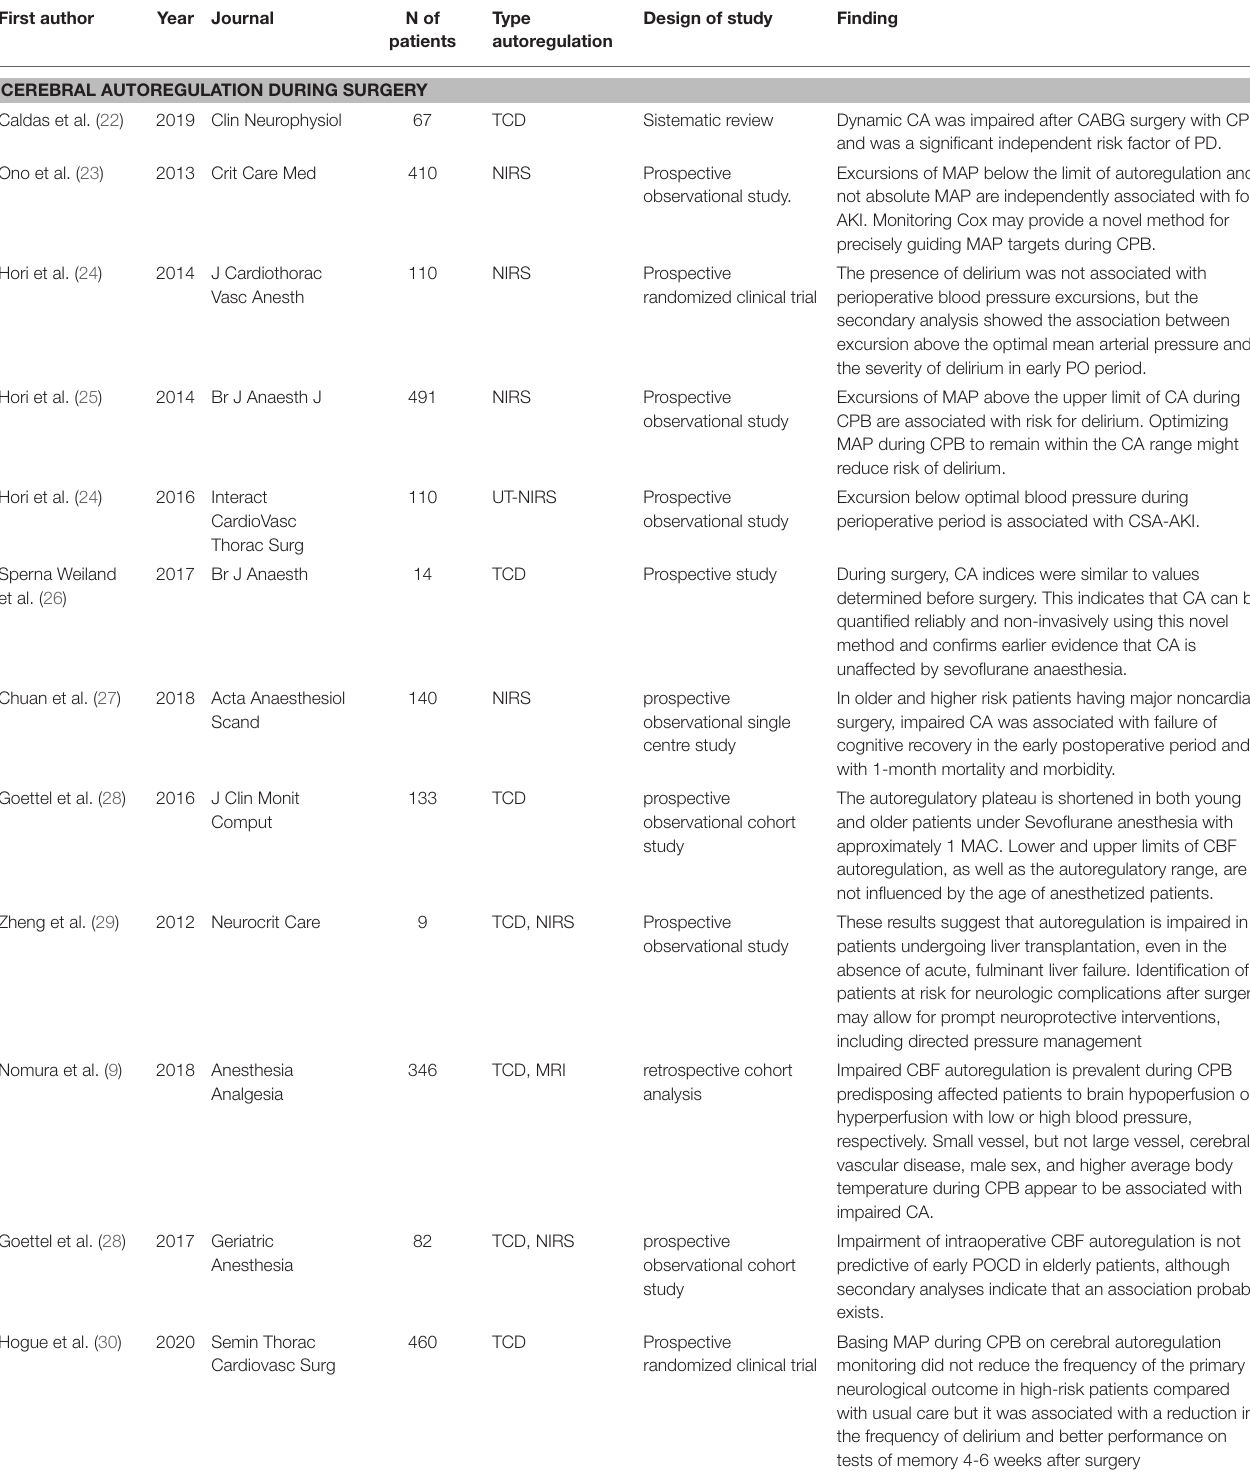
TABLE 2 | Summary of the included studies about CA in surgery: primary findings, type of method to assess autoregulation, number of patients